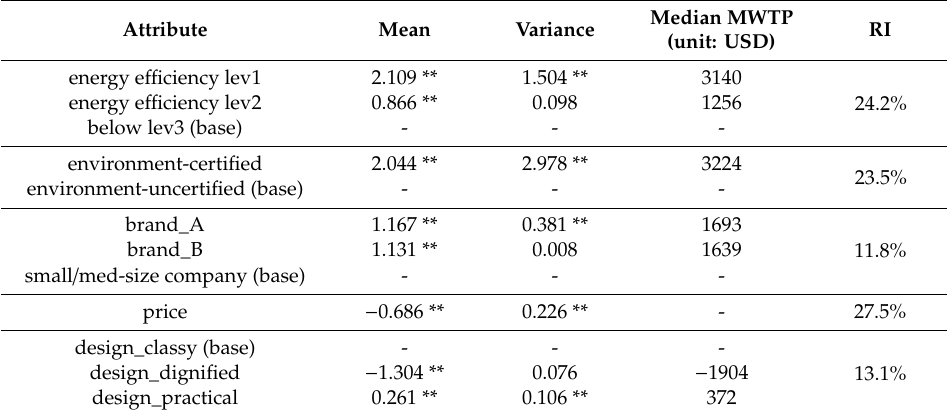
Table 5. Estimation results for the preferences of the window sets’